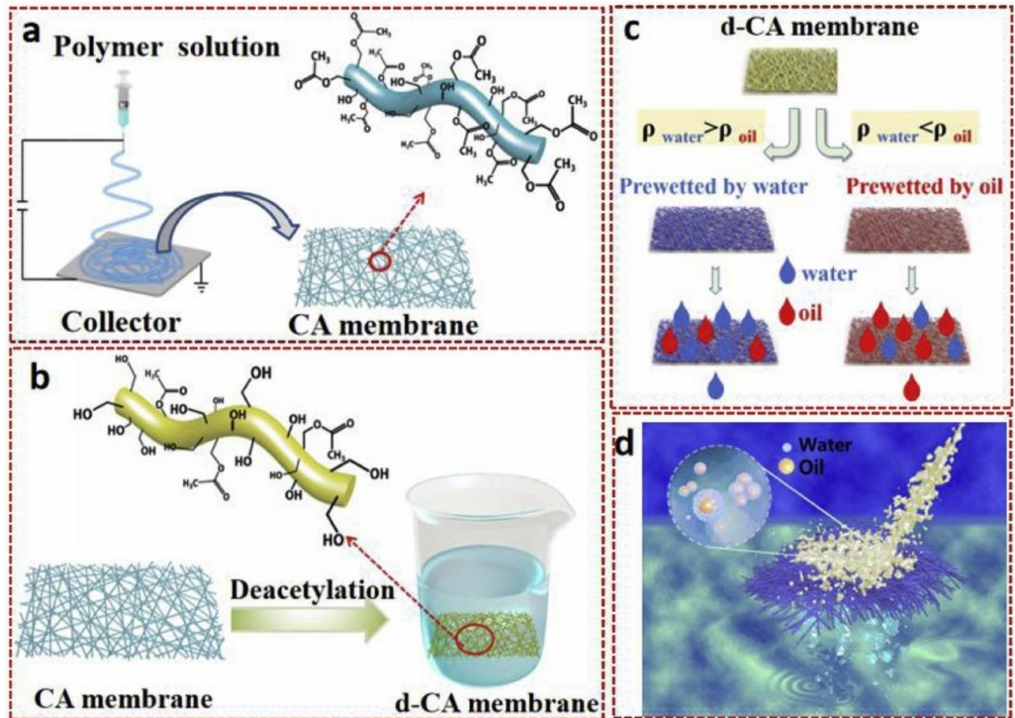
Figure 6. Formation of dual super-amphiphilic modified cellulose acetate nanofiber membranes by electrospinning, with highly efficient oil/water separation and excellent antifouling properties, ( a ) Electrospinning process to prepare cellulose acetate nanofiber membrane; ( b ) Deacetylation process to form d-CA; ( c ) Prewetted process to form amphiphilic structure; and ( d ) super-amphiphilic structure to separate water and oil [163]. ©Elsevier, 2020. CA, cellulose acetate nanofiber; d-CA, dual super-amphiphilic modified cellulose acetate nanofiber.